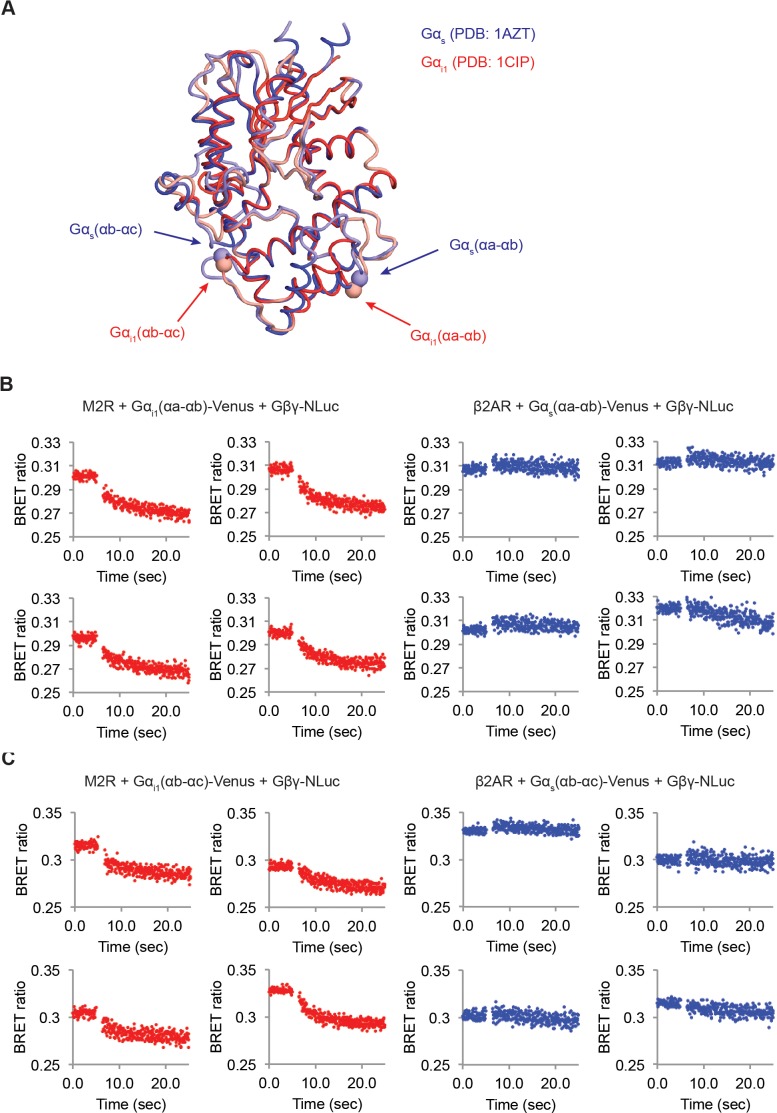
M2Rs catalyze release of Gβγ at higher rate compared to β2ARs.(A) Structural comparison between Gαs and Gαi1. Crystal structures of Gαs (Blue, PDB: 1AZT) and Gαi1 (Red, PDB: 1GG2) were superimposed. The Venus insertion sites are indicated as arrows. The Cα atoms of residues Gαs-113 and 144, and Gαi1-91 and 121 are represented as spheres. (B) (C) Time-resolved BRET ratio curves from HEK-293T cells transiently transfected with different GPCRs and Gα-Venus constructs.